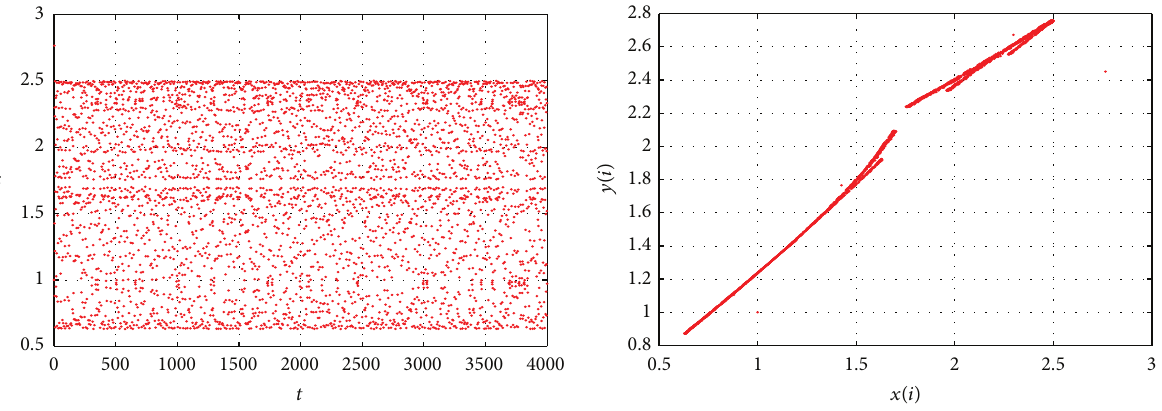
Figure 3: The portraits for several values of 𝐴 1 = 0.18 , 𝛿 = 6.4 .